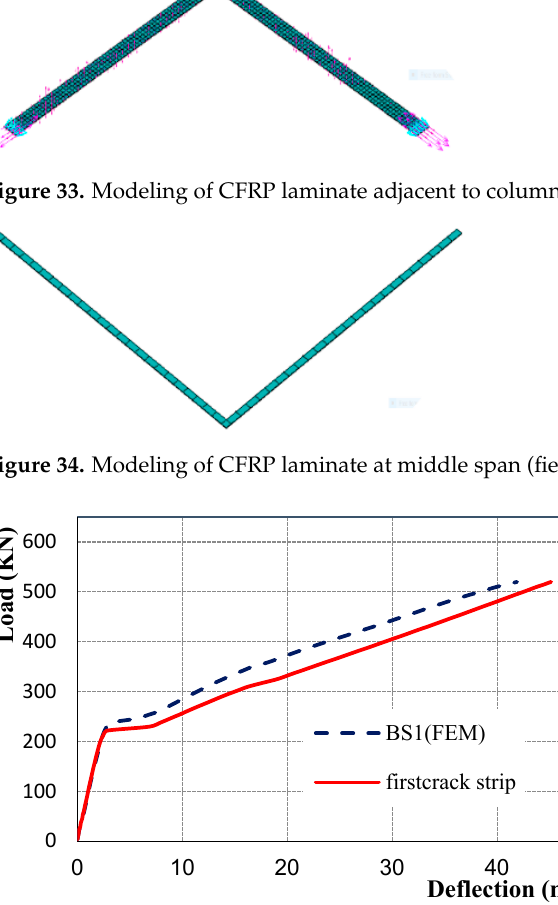
Figure 35. Comparison between column laminate results with BS1.